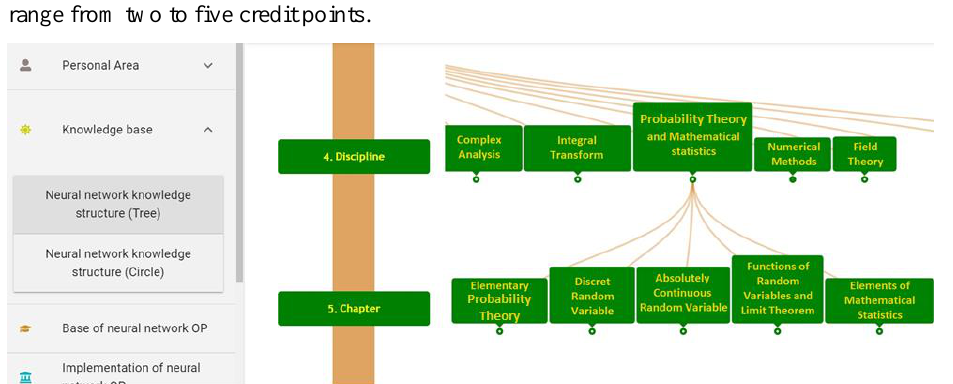
Fig. 1. Structure of the PTMS e-course in the DLS Nomotex: division into chapters .